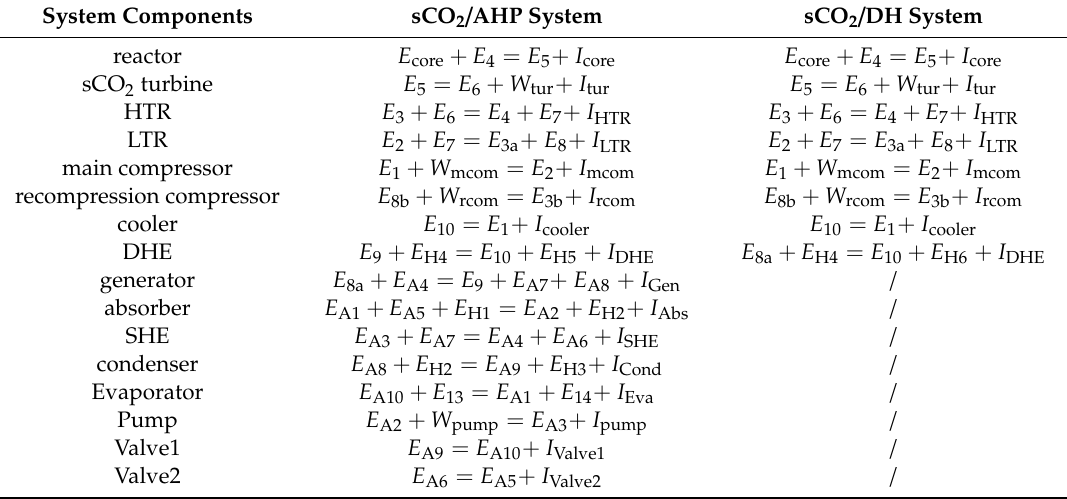
Table 1. Exergy balance equations for the sCO 2 / AHP system and sCO 2 / DH